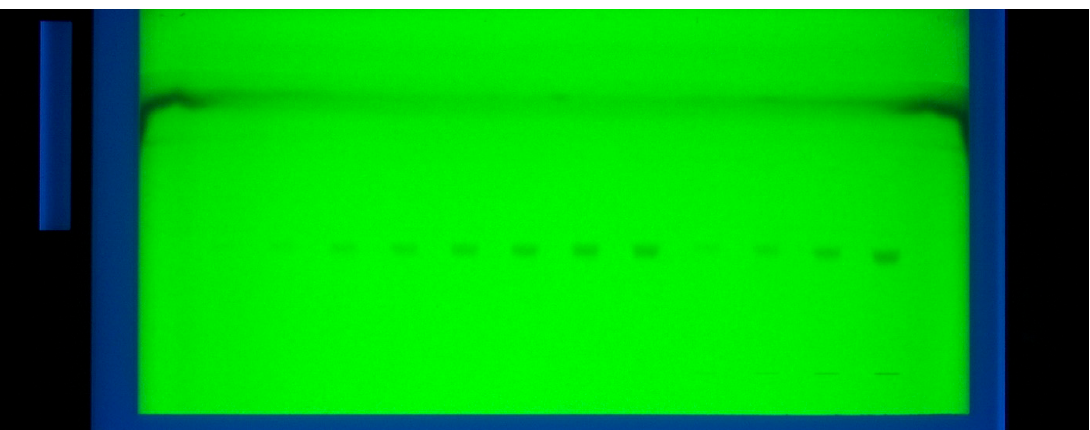
Figure 1. Pictorial diagram for the developed TLC plate for DLFX analysis.